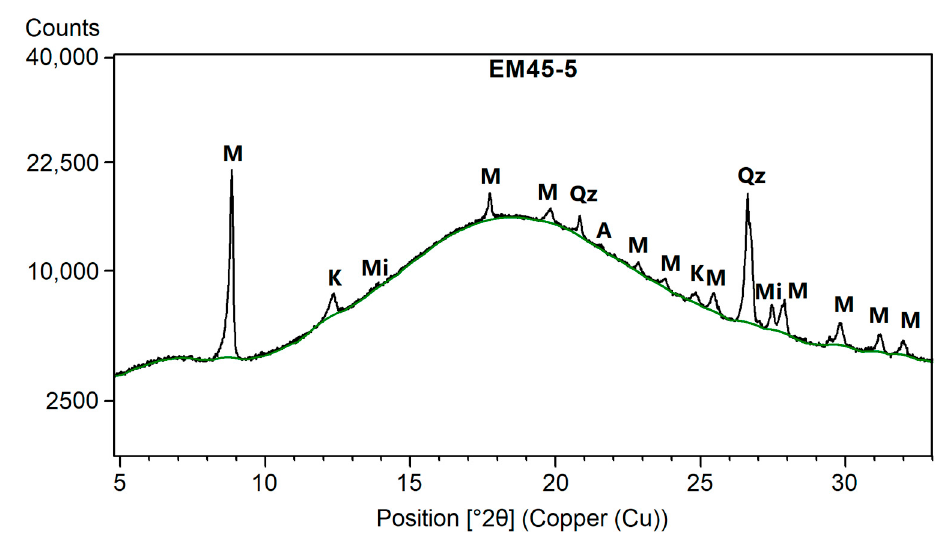
Figure 4. XRD of the EM45-5 sample (M = muscovite, K = kaolinite, Mi = microcline, A = albite, Qz = quartz).